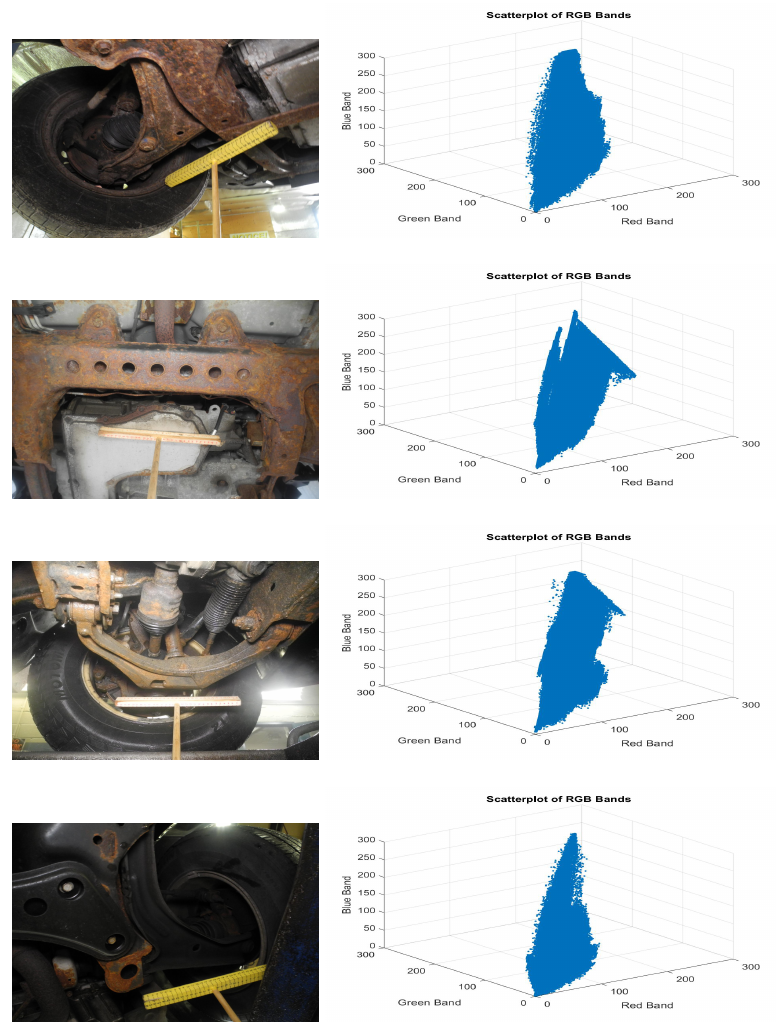
Figure 2. Input images of vehicle underbody parts under different illumination ( left ) and respective correlation visualization among the RGB bands ( right